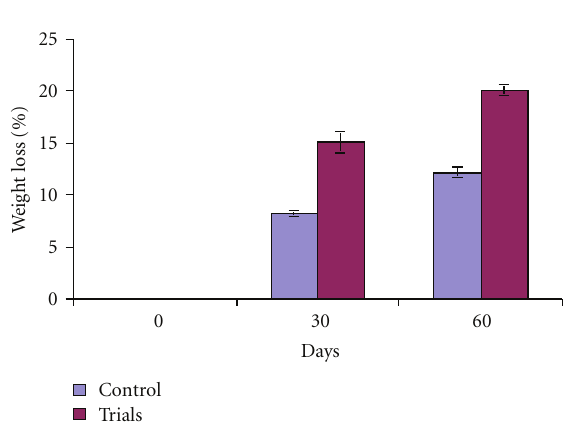
Figure 6: Percent weight loses of municipal solid waste by spore suspension of T. viride in plates (5g).